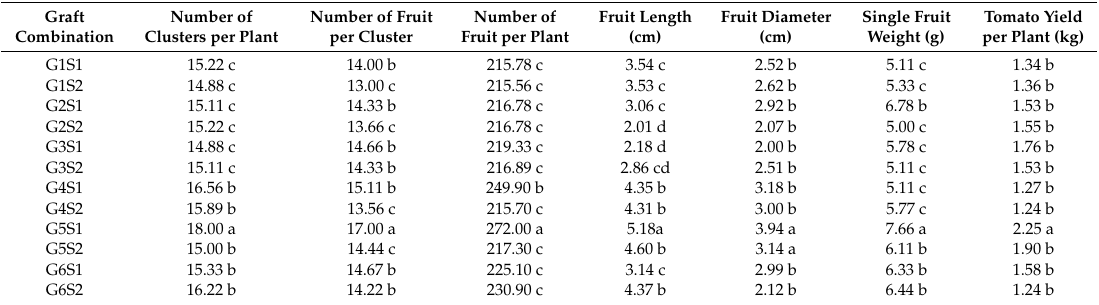
Table 4. E ff ect of di ff erent graft combinations on tomato fruit yield of pomato plants. Table 4. Effect of different graft combinations on tomato fruit yield of pomato plants. Graft Number of Combination Clusters per Graft combination Number of Clusters per Plant